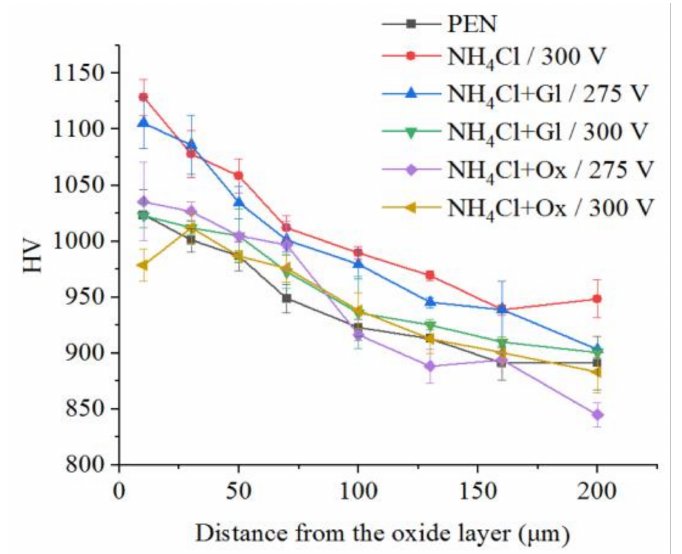
Figure 14. Distribution of microhardness in the surface layer of steel after PEN and subsequent PEP in ammonium chloride (3%) solution at a temperature of 80 ◦ C without or with glycerol or oxalic acid additions (5% each) at different voltages under forced electrolyte